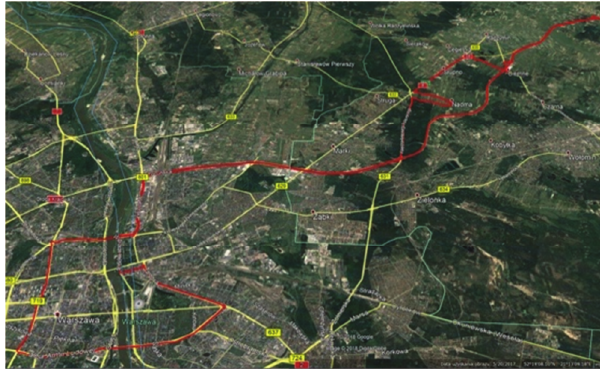
Fig. 1. RDE research